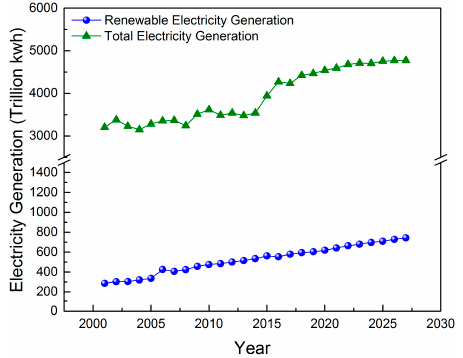
Figure 2. OLS projection of renewable and total energy used in electricity generation.